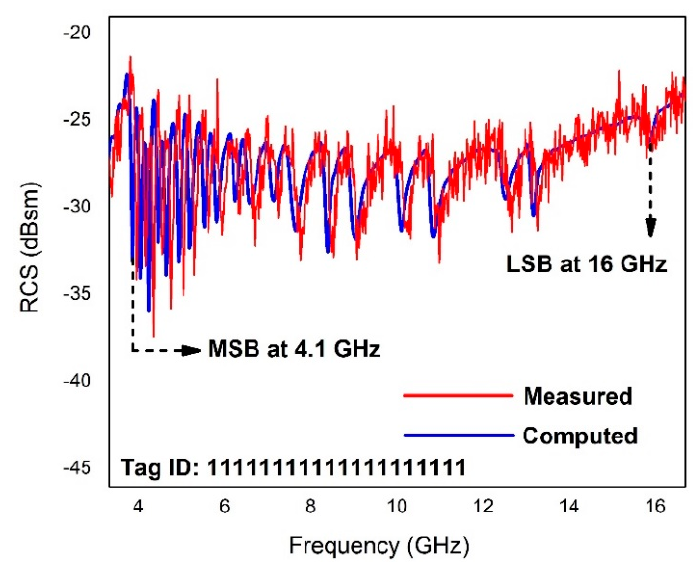
Figure 11. Computed and Measured RCS response.